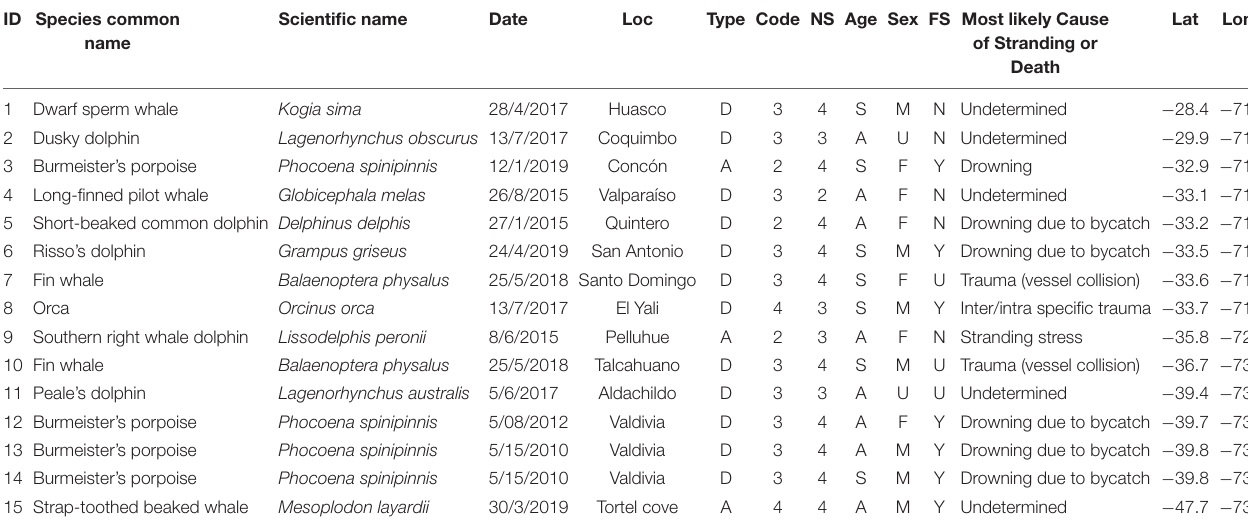
TABLE 1 | Overview of cetaceans sporadically stranded along the Chilean coast and necropsied between May 2010 and April